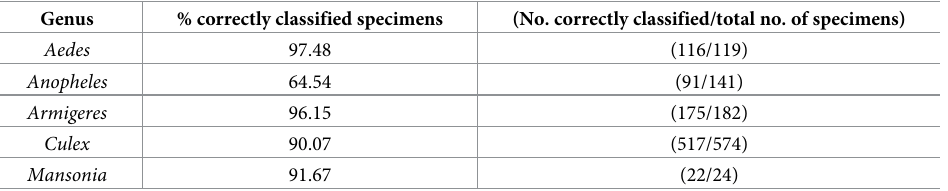
Table 2. Percentage of specimens correctly classified by